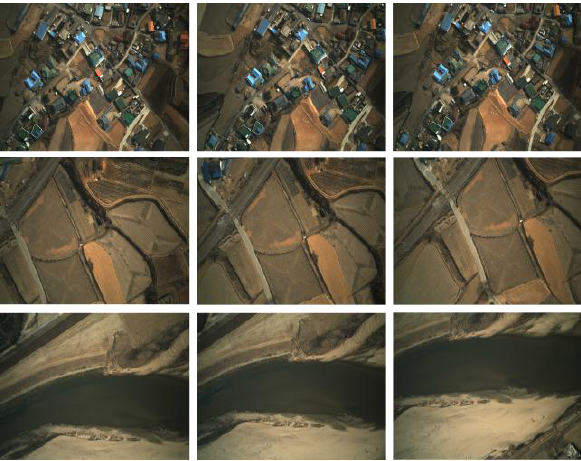
Figure 11. Sample images obtained from our system